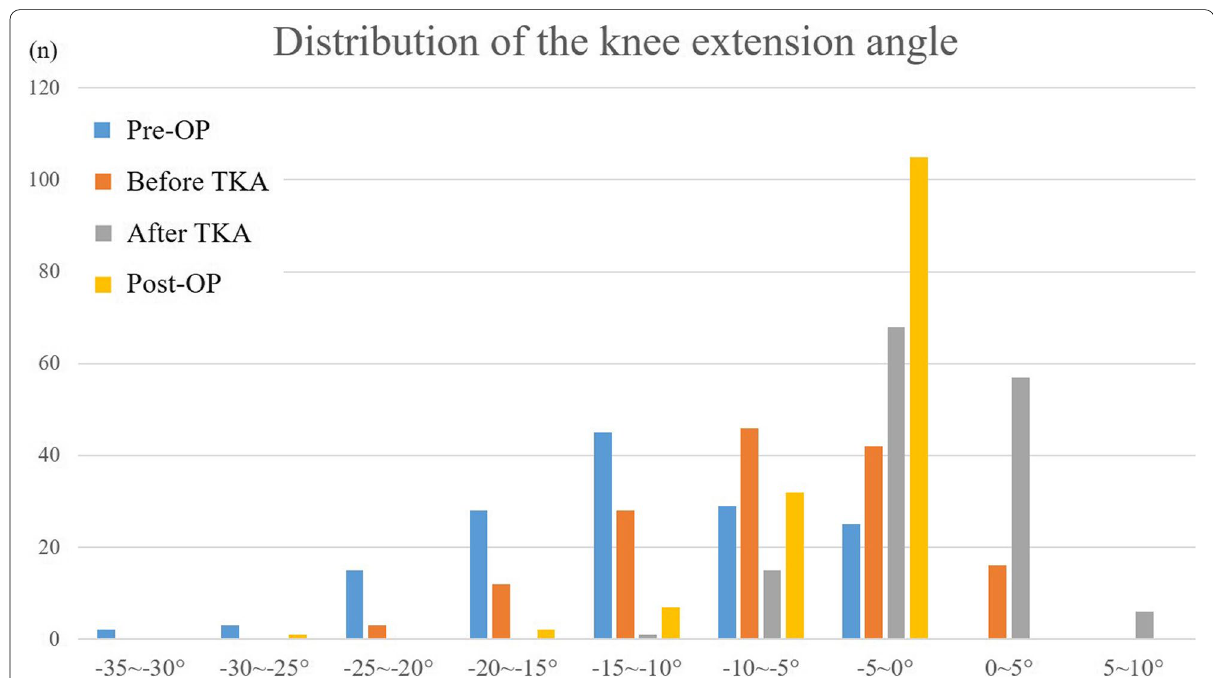
Fig. 3 Distribution of preoperative, intraoperative, and postoperative knee extension angles. Pre-OP, preoperative knee extension angle; Before TKA, Intraoperative maximum knee extension angle before TKA; After TKA, Intraoperative maximum knee extension angle after TKA; Post-OP, postoperative knee extension angle at 6 months after TKA